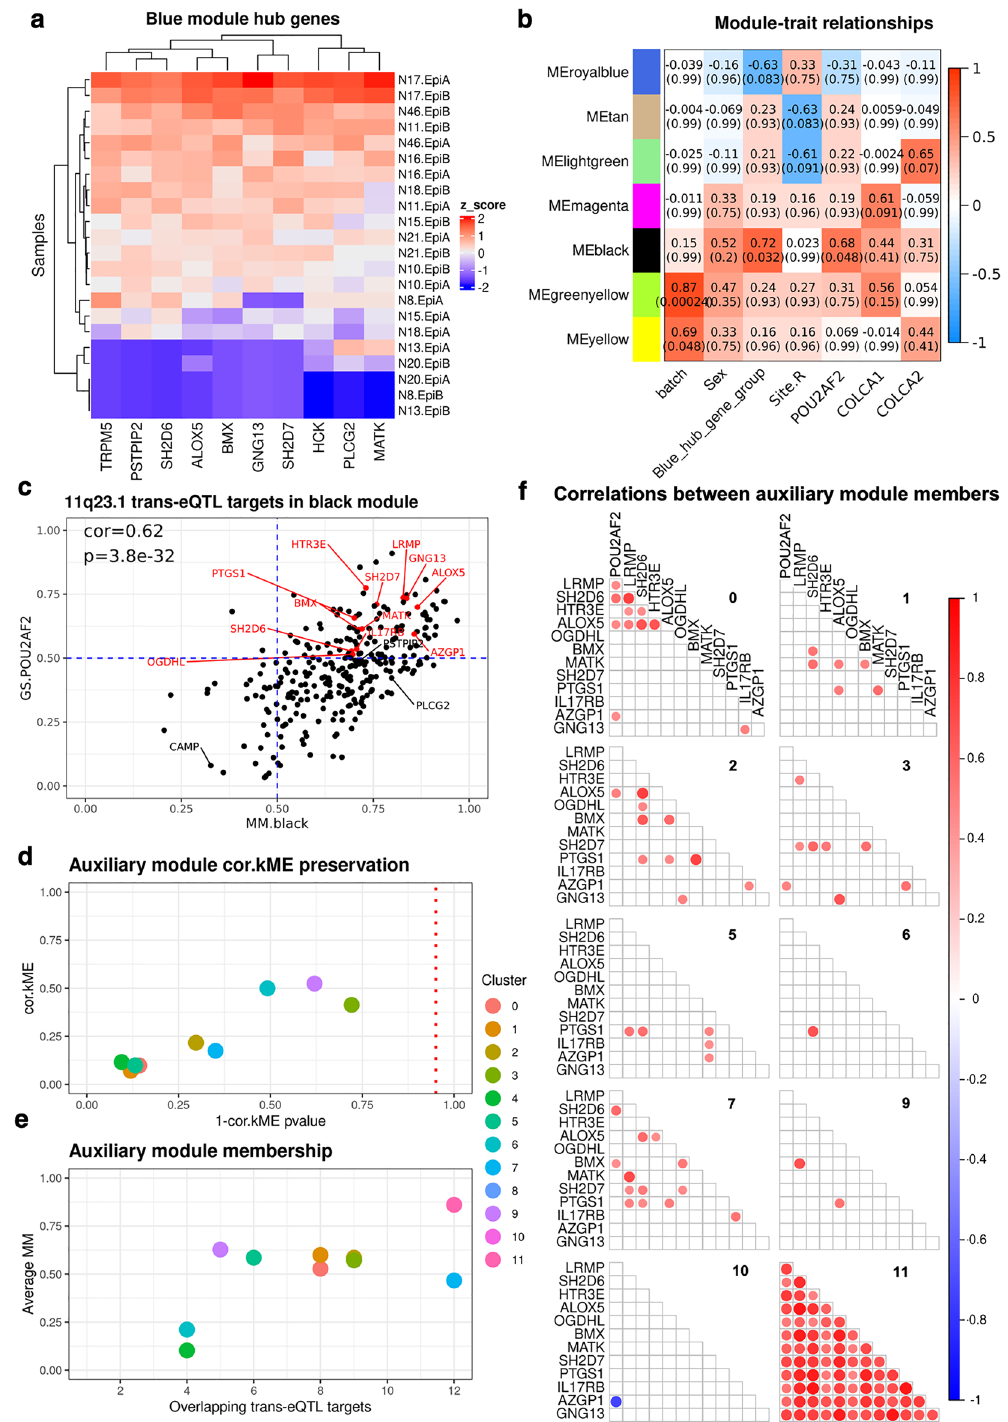
Figure 4. Several 11q23.1 trans-eQTL targets comprise POU2AF2- correlated network in tuft-like cluster only. ( a ) Relative (z-score) expression of blue module hub genes from Fig. 1d (MM > 0.7, kIM > 0.7, adj > 0.3). Robustness assessed by 10,000 permutations: p = 0.055. ( b ) Module trait matrix of gene modules identified by WGCNA within pseudo-bulked expression from cluster 11. Only modules exhibiting a correlation with a covariate (FDR < 0.1) are shown. Total number of modules = 20. ( c ) Correlation of Gene Significance (GS) and Module Membership (MM) of genes in the black module from ( b ). 11q23.1 trans-eQTL targets are highlighted. 11q23.1 trans-eQTL targets with GS.POU2AF2 > 0.5 and MM.black > 0.5 (red) were used as the auxiliary module. ( d ) Preservation of correlations between auxiliary module genes with the module eigengene (ME) and equivalent values in cluster 11. Dashed line indicates nominal significance threshold (p = 0.05). ( e ) Average MM of genes within the auxiliary module across clusters. ( f ) Pairwise Pearson correlations (p < 0.05) between the pseudo-bulked expression of auxiliary module genes across clusters. Cluster number in upper right of each facet. Cluster 4 and 8 exhibited no significant (p < 0.05) correlations and so are not